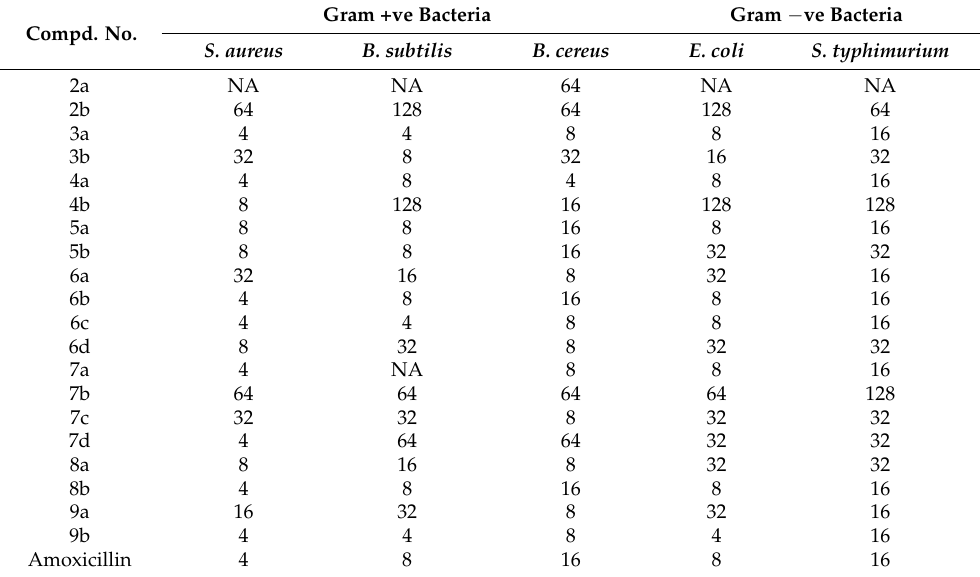
Table 1. In vitro antibacterial activities of the synthesized compounds expressed as MICs ( µ g/mL) against the tested pathogenic bacteria. Compd. No.